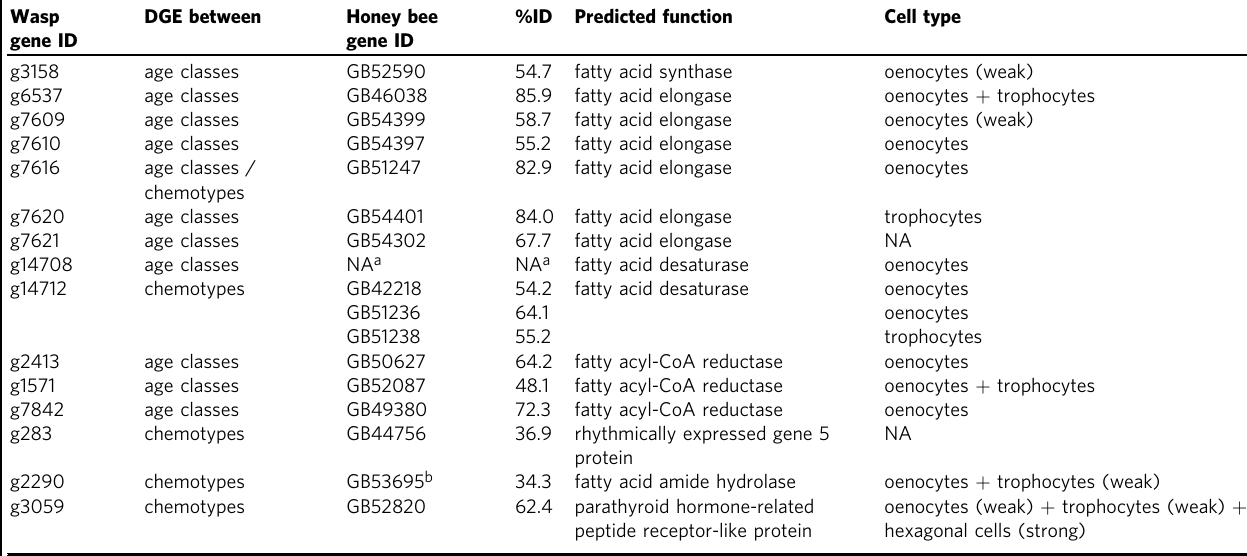
The table informs about 1) the mason wasp gene ID, 2) between which groups differential expression differences (DGE) were detected, 3) orthologous/homologous genes in the honey bee ( Apis mellifera )genome, 4) the percentageof identical amino acidsbetweenthe encodedsequencesof the mason waspand those of the honeybee, 5)the genes ’ predicted functions, and 6) the expression of the candidate genes in honey bee fat body cells. a Since we found no 1:1 ortholog in the honey bee genome, we assessed the phylogenetically most closely related homolog, GB40659 (39.6%), for being involved in CHC biosynthesis. b One of three co-orthologs in the honey bee, the other two being GB48850 (36.4%) and GB47832 (34.3%) (not studied by